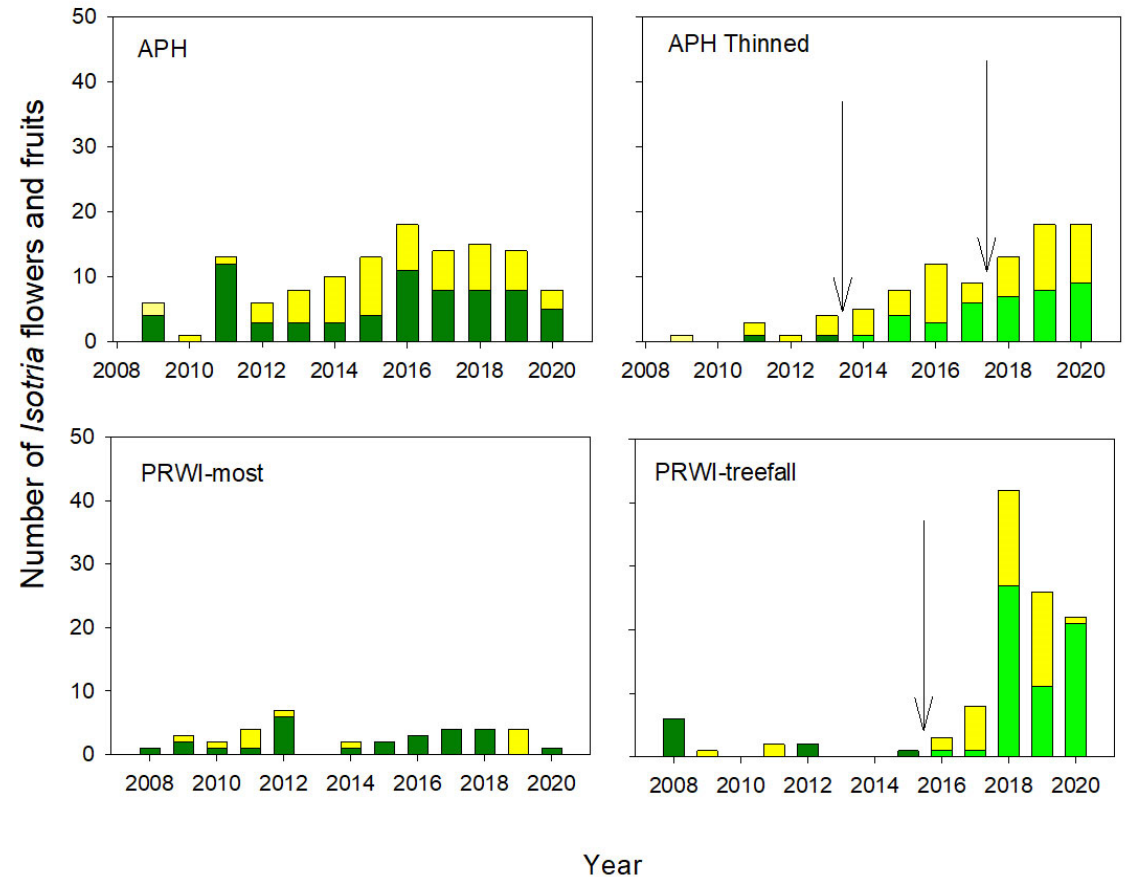
Figure 5. Flowering (green) and fruiting (yellow) in non-thinned (graphs on the left) and thinned (APH) areas, or where a canopy tree died at PWRI (graphs on the right). Color codes and arrows are as described in the legend of Figure 3.